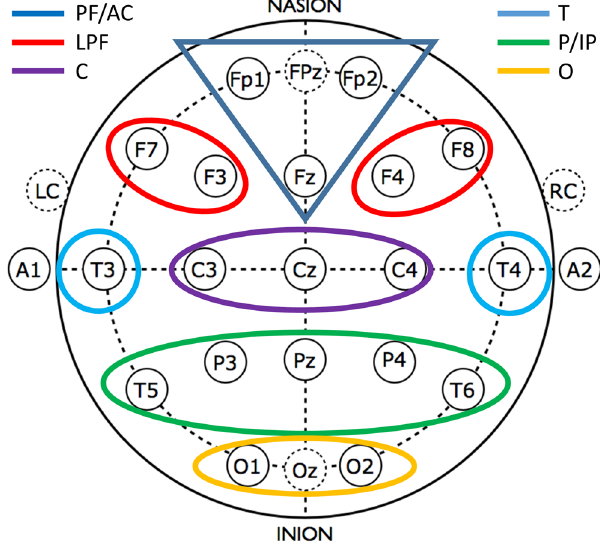
Figure 8. Areas defined for the region-specific analyses of